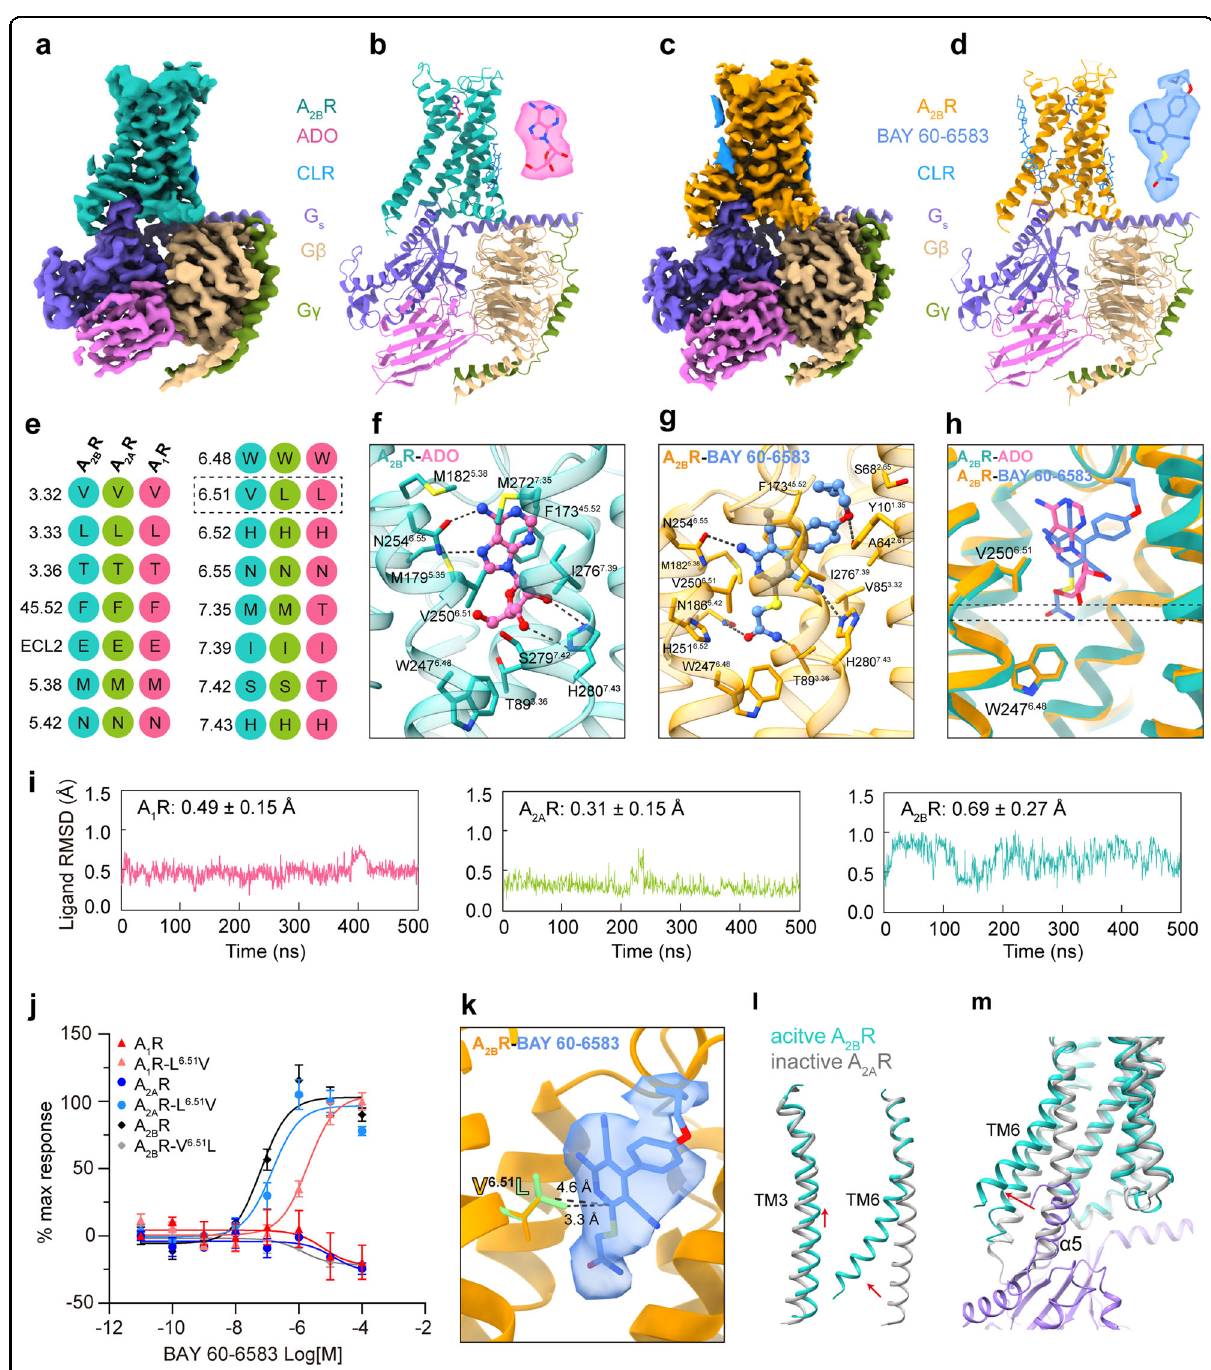
Fig. 1 Cryo-EM structures of A 2B R bound to the endogenous ligand ADO and a selective non-nucleoside agonist BAY 60-6583. a , b Cryo-EM map ( a ) and structural model ( b ) of the ADO – A 2B R – G s complex. c , d Cryo-EM map ( c ) and structural model ( d ) of the BAY 60-6583 – A 2B R – G s protein complex. The ADO ( b ) and BAY 60-6583 ( d ) with their density maps are shown. e The sequence alignment of the residues in the ADO-binding pocket among three ARs. f ADO-binding pocket in A 2B R. Hydrogen bonds are shown as black dashed lines. g BAY 60-6583-binding pocket in A 2B R. h Structure superposition of ADO – and BAY 60-6583 – A 2B R complexes. Two dashed lines indicate the inserting depth of ADO and BAY 60-6583. i The RMSDs of ADO in A 1 R, A 2A R, and A 2B R binding pockets. j Effects of BAY 60-6583 on the wild-type and mutated ARs with the swapped leucine/valine at position 6.51. NanoBiT Assay was performed to evaluate ligand activity in three independent experiments in triplicate ( n = 3). k Potential steric hindrance between BAY 60-6583 and L 6.51 . The mutation was generated by the software PyMOL. l , m Conformational comparison of A 2B R and the inactive A 2A R (PDB: